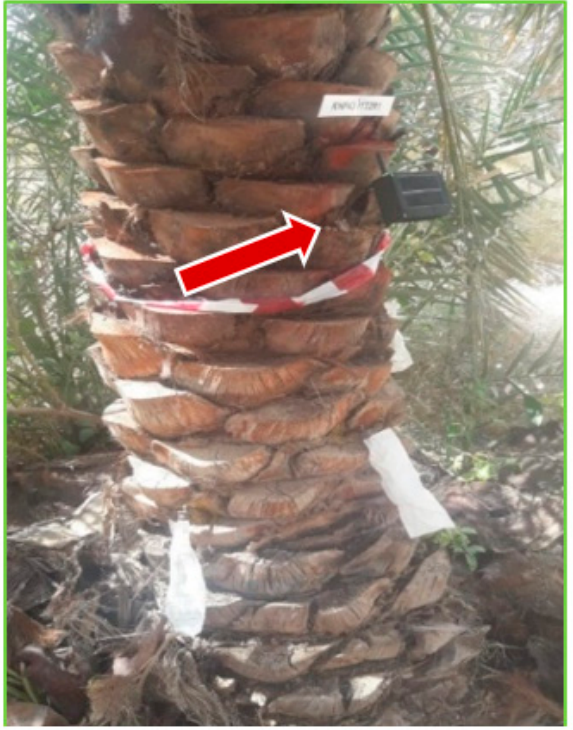
Figure 3. The installed acoustic sensor on a date palm trunk. The arrow is showing the device probe inserted inside the date palm tree trunk.